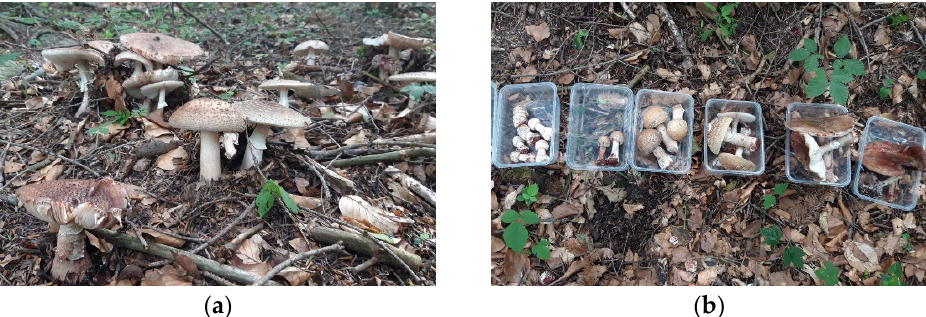
Figure 1. Amanita rubescens Pers: ( a ) Sampling place with different fruiting body developmental stages; ( b ) collected samples of six developmental stages in PE boxes.